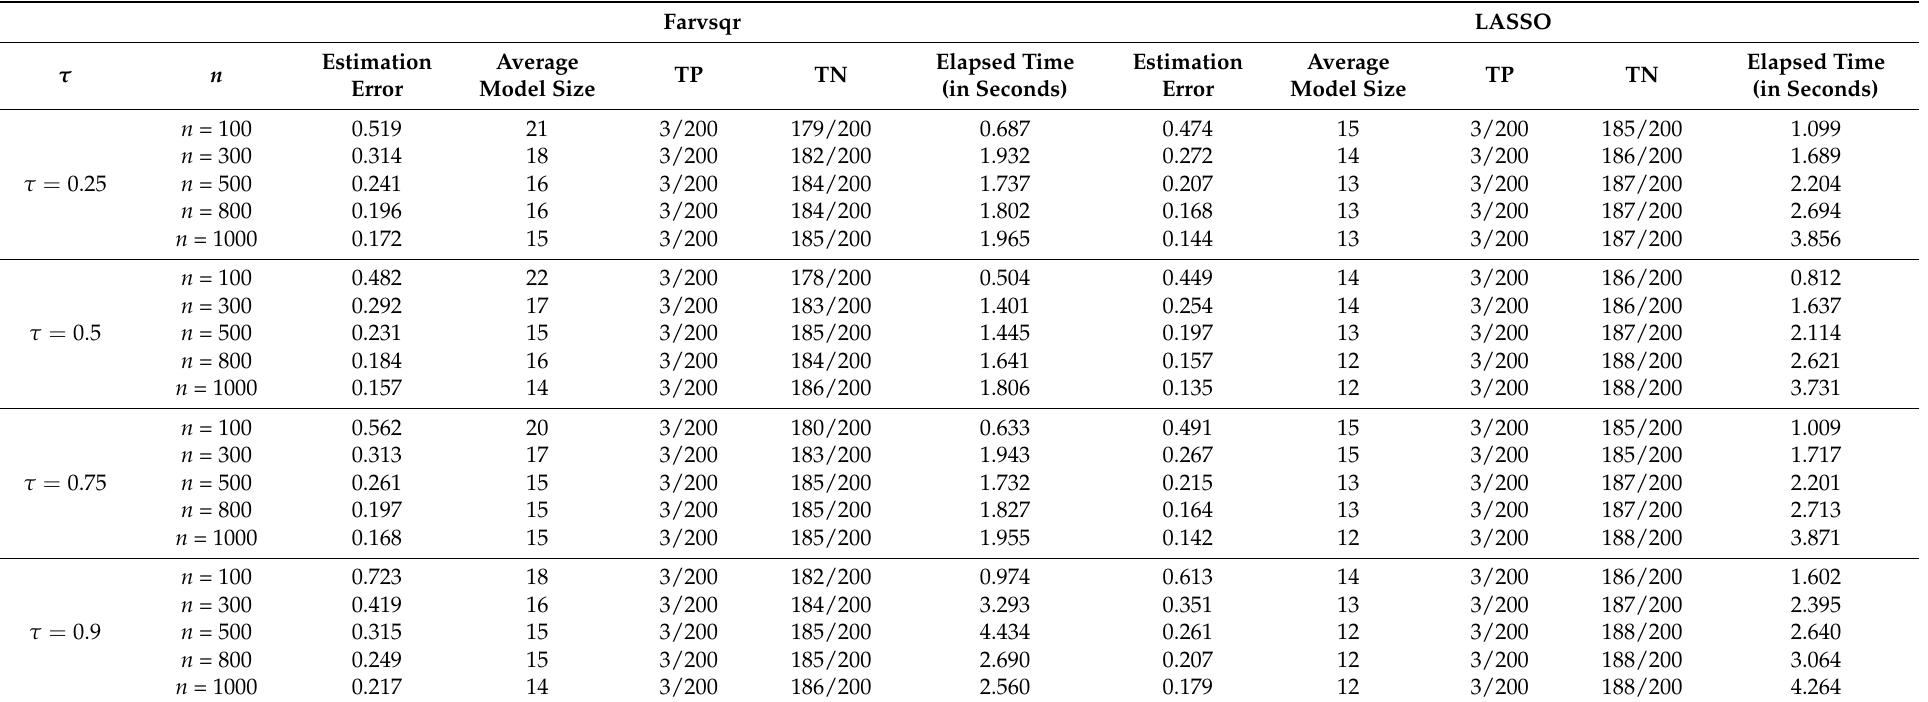
Table 7. The comparison for p = 200, N ( 0,1 ) with the equal correlated case. Farvsqr